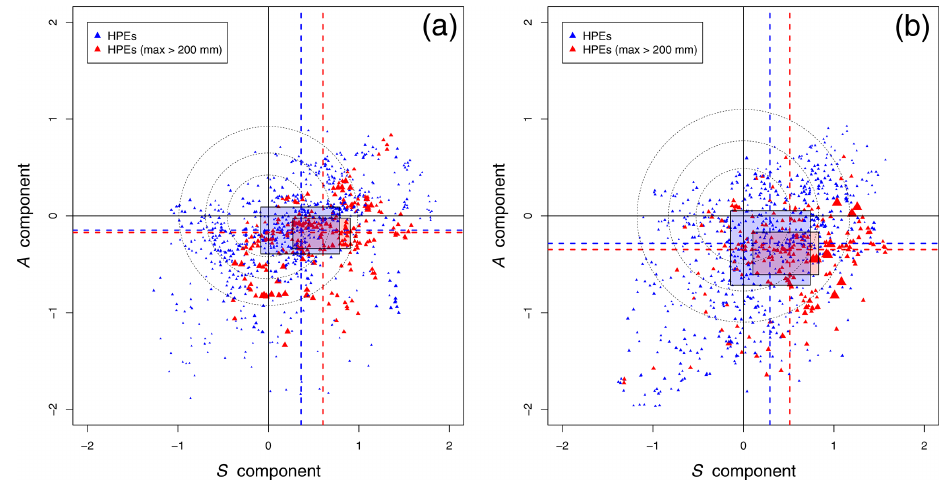
Figure 6. Relationship between the A component and the S component of the SAL score (SAL diagrams) for HPEs only, for lead times LT12 (a) and LT34 (b) . Blue triangles represent HPEs with grid-point maximum rainfall under 200mmd − 1 , and red triangles show rainfall amounts above 200mm. Triangles are proportional to the rainfall value. Some main characteristics of the component distribution are plotted. The median value is shown as dashed lines, and percentiles 25 and 75 delimitate the boxes. Circles represent the limits 25th, 50th, and 75th percentiles to the best score ( A = 0, S = 0).